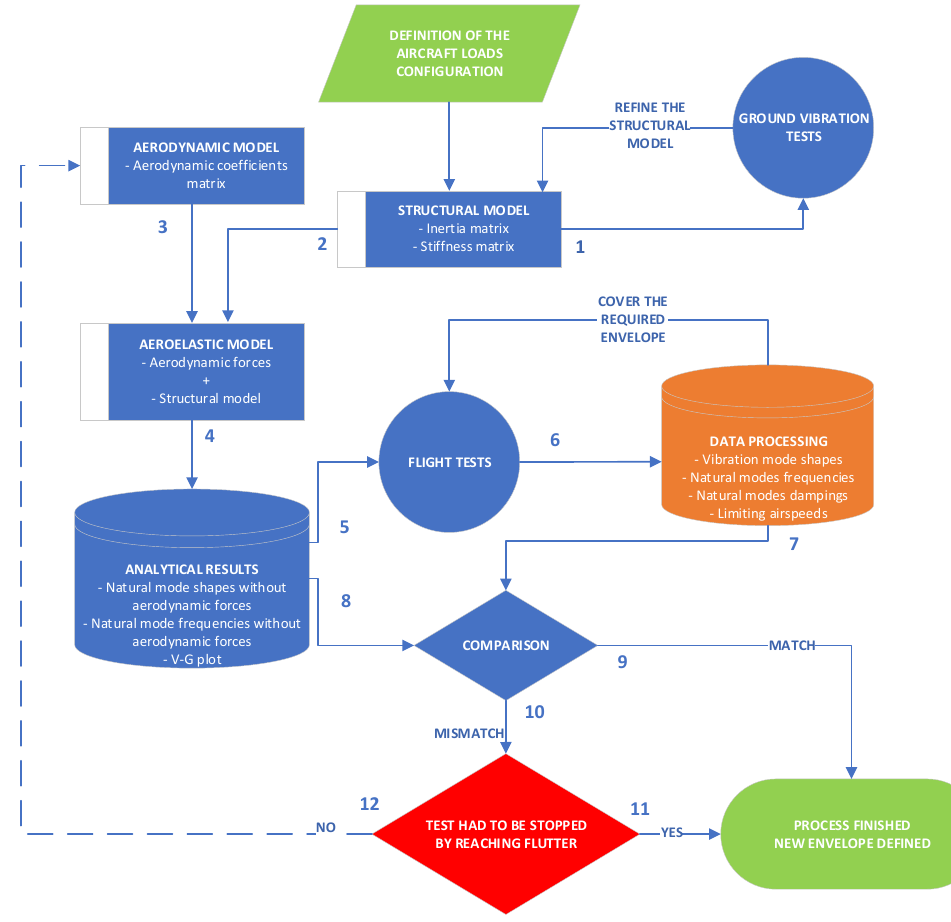
Figure 5. Stores integration paradigm particularized to Aeroelastic Flutter limiting factors. The stop point is reached either when flutter conditions have been found during flight or when the confidence on the accuracy of the model is high enough as to allow for a safe extrapolation of the flutter